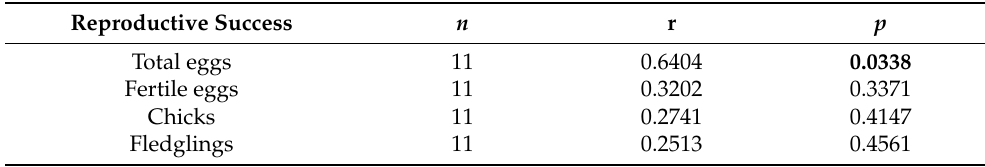
Table 2. Relationship between fecal glucocorticoid metabolite levels in females during the pre- breeding season and reproductive success variables †.